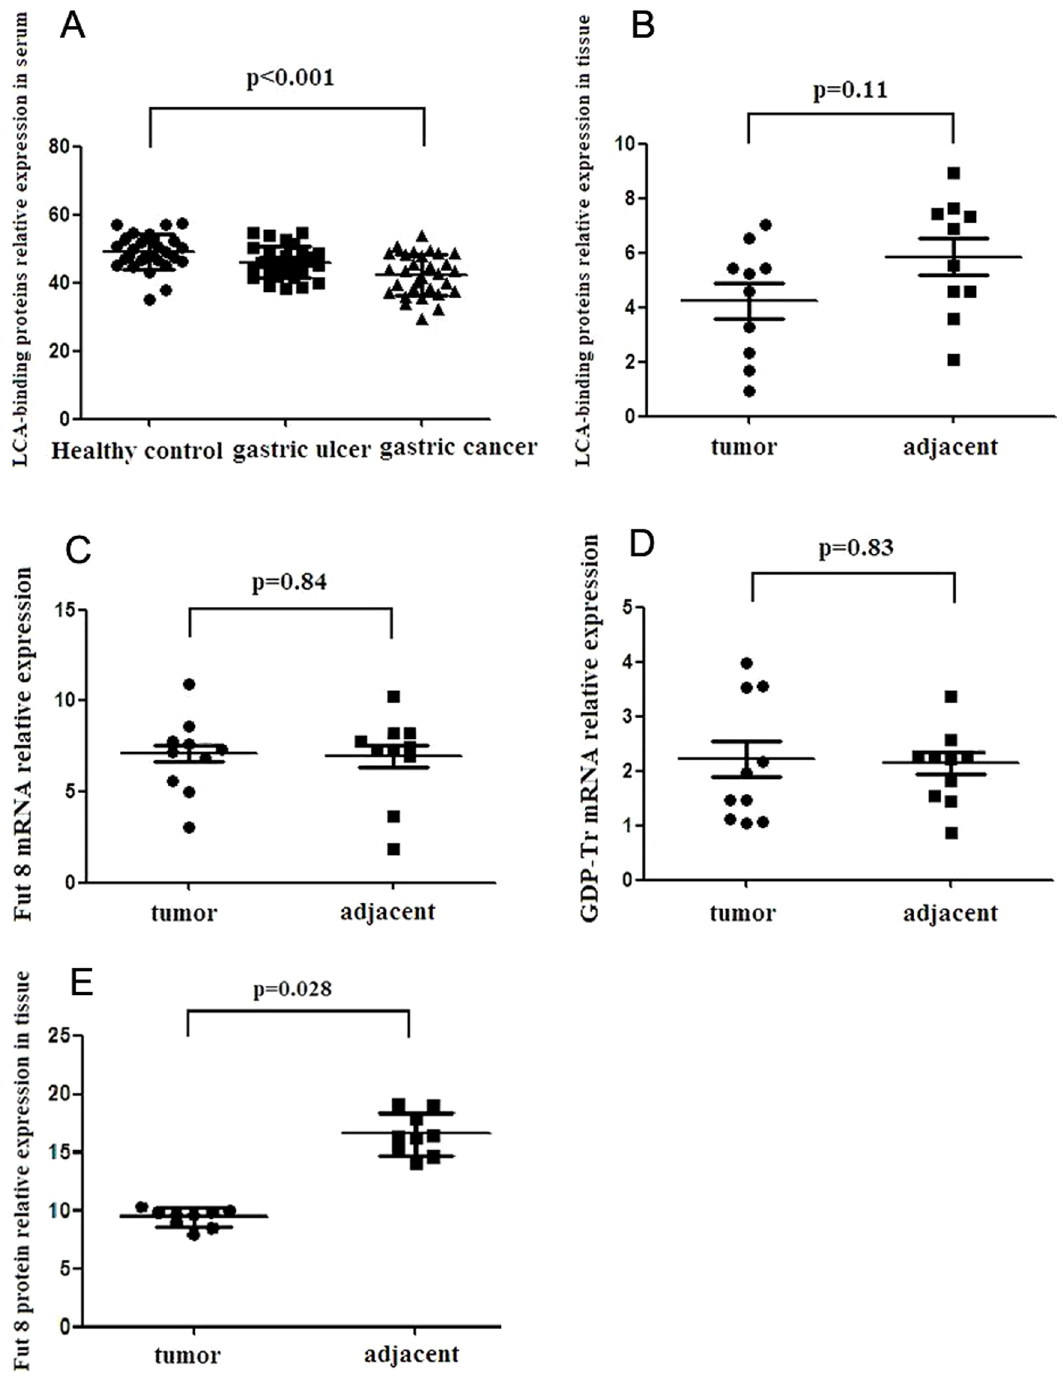
Figure 3. The abundance of total core-fucosylated residues from lens culinaris agglutinin A (LCA) lectin blot, mRNA level of a -1,6- fucosyltransferase (Fut8), guanosine diphosphate (GDP)-fucose transporter (GDP-Tr) from quantitative RT-PCR, and protein level of Fut8 from western blot. (A) Lectin blots of serum proteins were probed with LCA. The horizontal axis represents the experimental groups: healthy control (n=30), gastric ulcer (n=25), and gastric cancer (GC) (n=30); the vertical axis indicates the ratio of fucosylated proteins to total proteins. The level of fucosylated proteins in gastric cancer is the lowest among 3 groups (P , 0.001). (B) Lectin blots from tissue proteins were probed with LCA. The horizontal axis represents the experimental groups: tumor tissues (n=10) and adjacent tissues (n=10). The vertical axis indicates the ratio of fucosylated proteins to total proteins. The core-fucosylated level was lower in gastric tumor, but the difference showed no statistical significance (P . 0.05). (C) and (D) Relative messenger RNA (mRNA) expression levels of Fut8 or GDP-Tr in tissues were measured by quantitative RT- PCR. The horizontal axis represents the experimental groups: tumor tissues (n=10) and adjacent tissues (n=10). The vertical axis indicates the relative expression levels of Fut8 or GDP-Tr. The difference between groups was not statistically significant (P . 0.05). (E) The relative abundance of Fut8 protein was illustrated using western blot. The horizontal axis represents the experimental groups: tumor tissues (n=9) and adjacent tissues (n=9). The vertical axis indicates the relative levels of Fut8 protein. The relative abundance of Fut8 protein in adjacent tissues was significantly higher than that in tumor tissues (P , 0.05). doi:10.1371/journal.pone.0094536.g003 PLOS ONE |